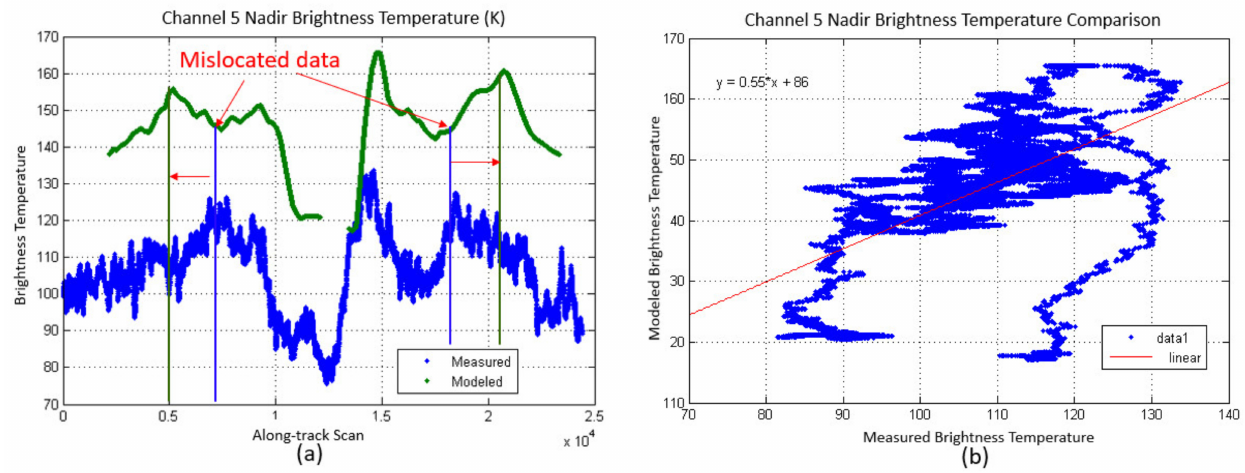
Figure 8. HIRAD 5.0 GHz measured T A (blue) and modeled T a (green) antenna brightness tempera- ture comparison, where ( a ) is a time series of along-track samples and ( b ) is the corresponding scatter diagram